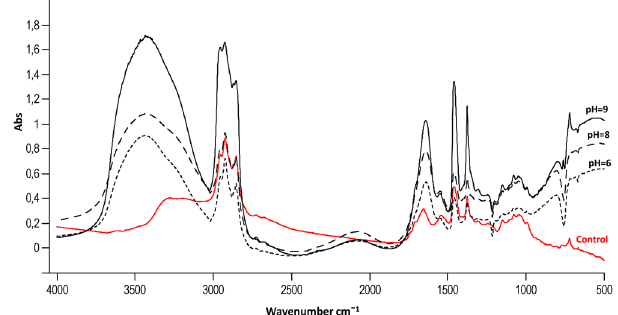
Figure 2. The FTIR spectra of unmodified and modified S . cerevisiae pellets at pH 6, 8 and